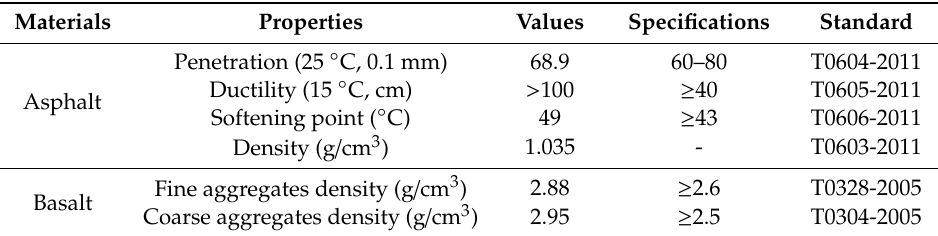
Table 1. Properties of SBS modified asphalt and basalt aggregate.